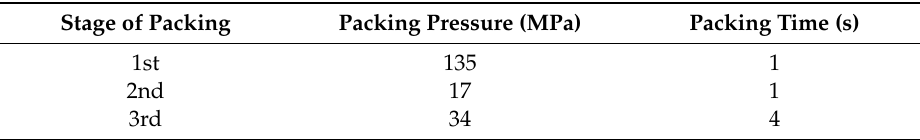
Figure 11. The pressure profile relative to: one-stage packing (warpage: 0.60 mm) ( top ); three-stage packing (warpage: 0.42 mm) ( bottom ). Table 3. Three-stage packing parameter settings.